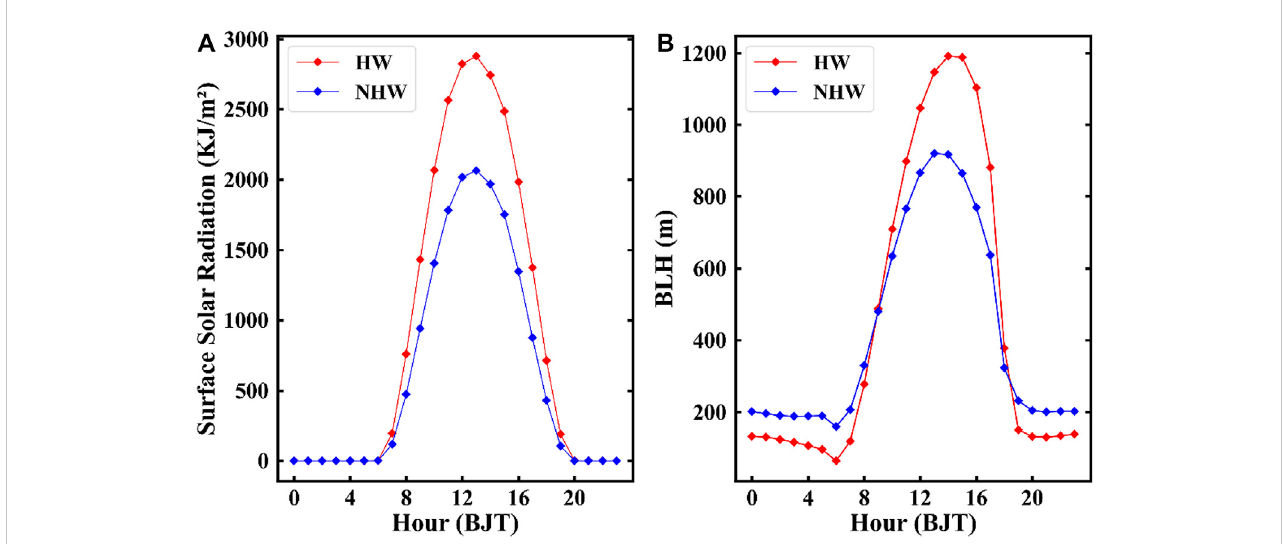
FIGURE 10 (A) Diurnal variation of surface solar radiation (downward),and (B) diurnal variation of average boundary layer height (BLH). The criterion for determining HW is that at least 6 or more stations are in HW period on that day. (BJT: Beijing time).